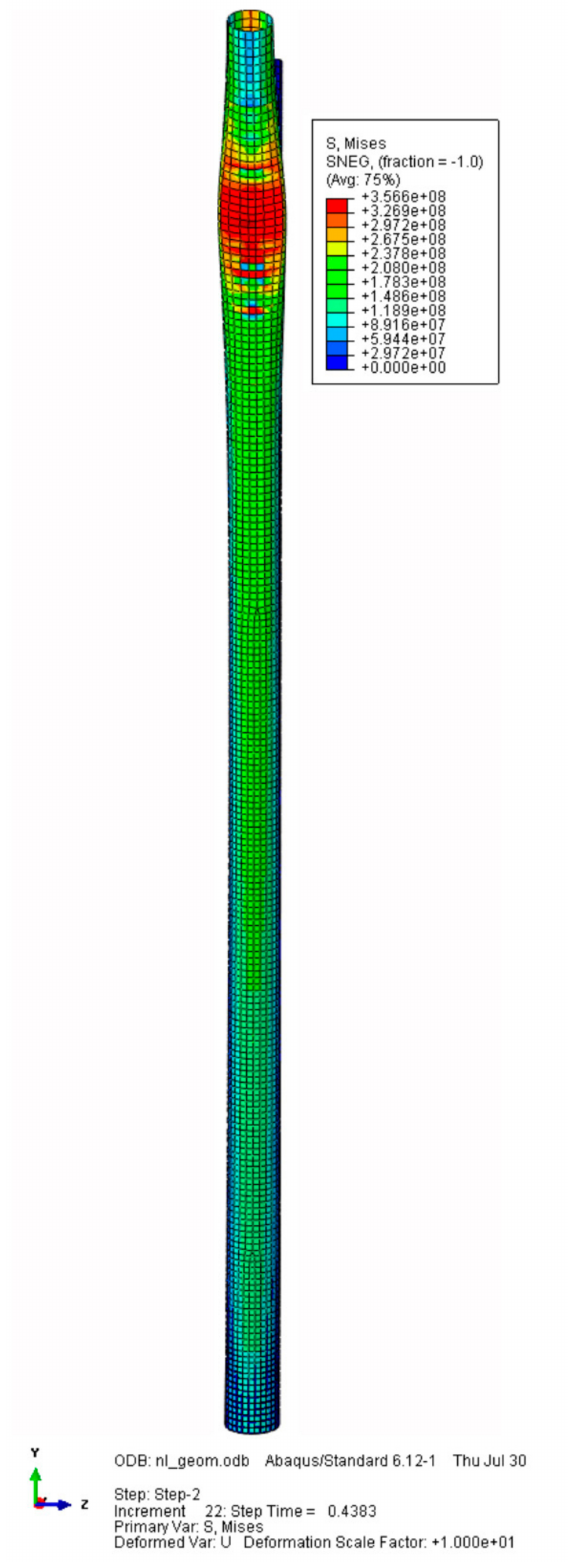
Figure 9. Material non-linear imperfection analysis results for